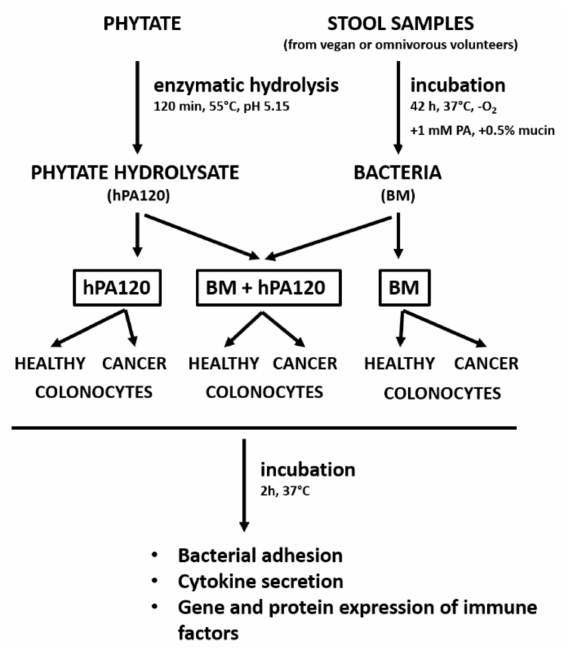
Figure 1. Experimental